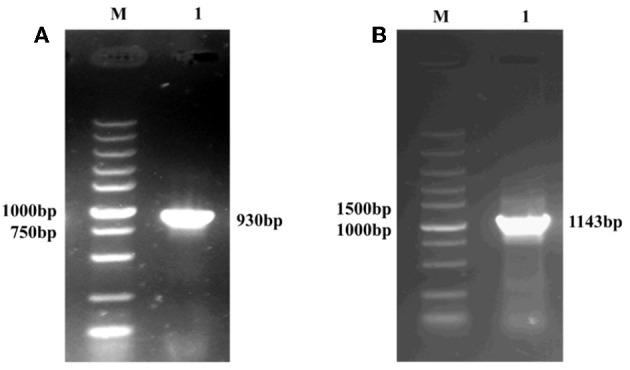
PCR amplification of the recombinant plasmid containing the gp85 gene (A) and the pgsA gene (B), M: DNA Maker; (A) 1: the PCR product predicted as 930 bp. (B) 1: the PCR product predicted as 1,143 bp.